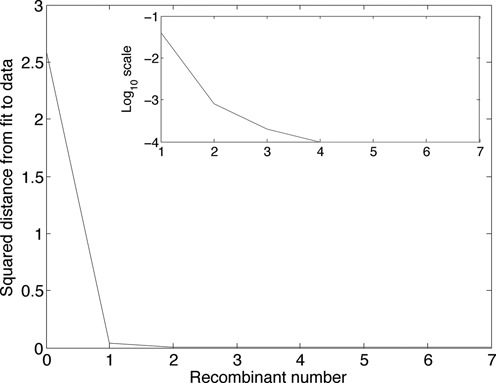
The squared distance between data point y and fitted point x, plotted against the number of recombinants fitted. In the example, the drops are 2.545, 3.971 × 10−2, 6.023 × 10−4, 1.267 × 10−4, 3.783 × 10−5, 3.451 × 10−7 and 2.143 × 10−8, the corresponding remaining squared distances are 4.053 × 10−2, 8.171 × 10−4, 2.148 × 10−4, 8.820 × 10−5, 5.036 × 10−5, 5.002 × 10−5 and 5.000 × 10−5, whence the successive F-values are 62.79, 48.60, 2.804, 1.437, 0.7512, 0.0069 and 0.0004, making the first two recombinants significant at the 1% level. The inset plots log10 of the squared distance against the number of recombinants.